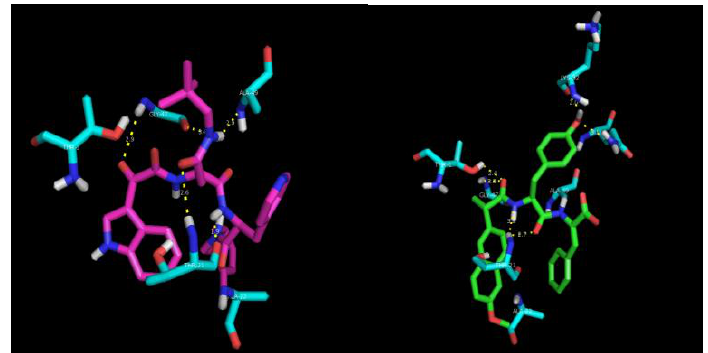
Figure 9. Best docking poses for an optimised non-covalent inhibitor (pink) of proteasome 20S and for compound 1 (green). The protein residues which interact with the inhibitors are coloured blue and the hydrogen bonds are represented by yellow dashed lines.